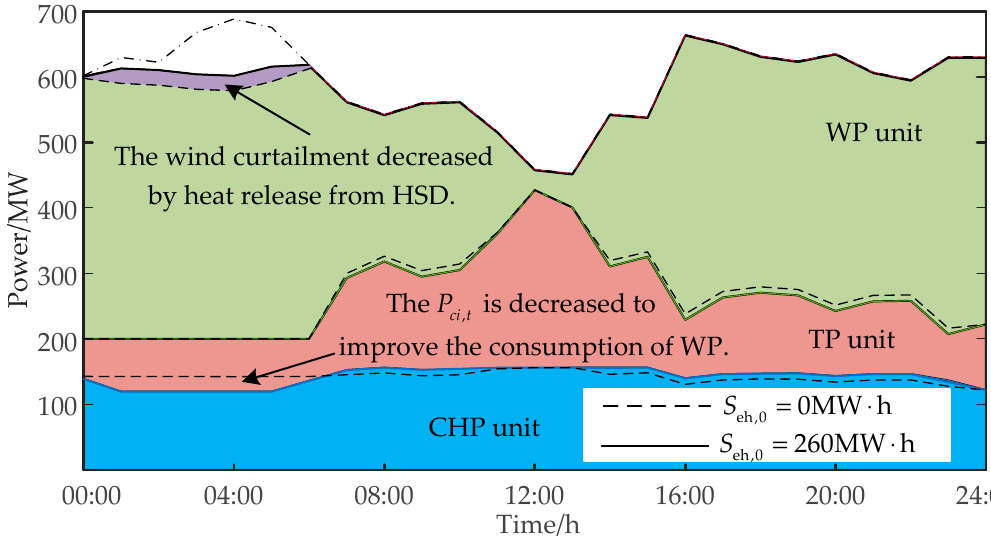
Figure 9. System operation results under di ff erent initial heat storage capacity.